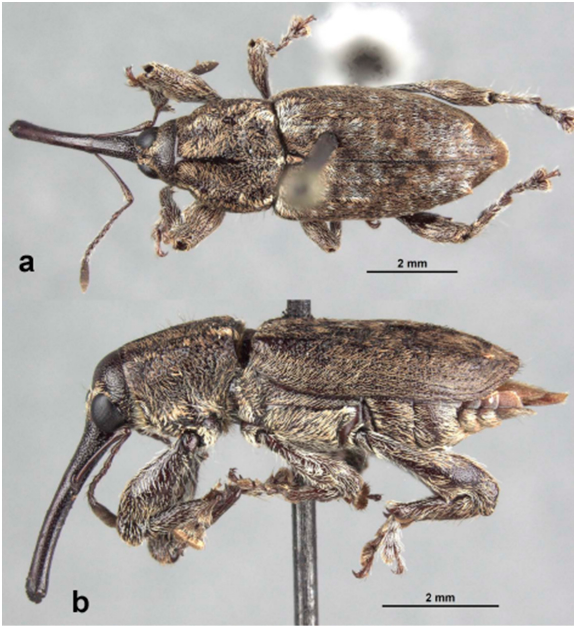
Figure 13. Kuschelorhinus hirsutus : ( a ) habitus of female, dorsal aspect; ( b ) habitus of female, lateral aspect.